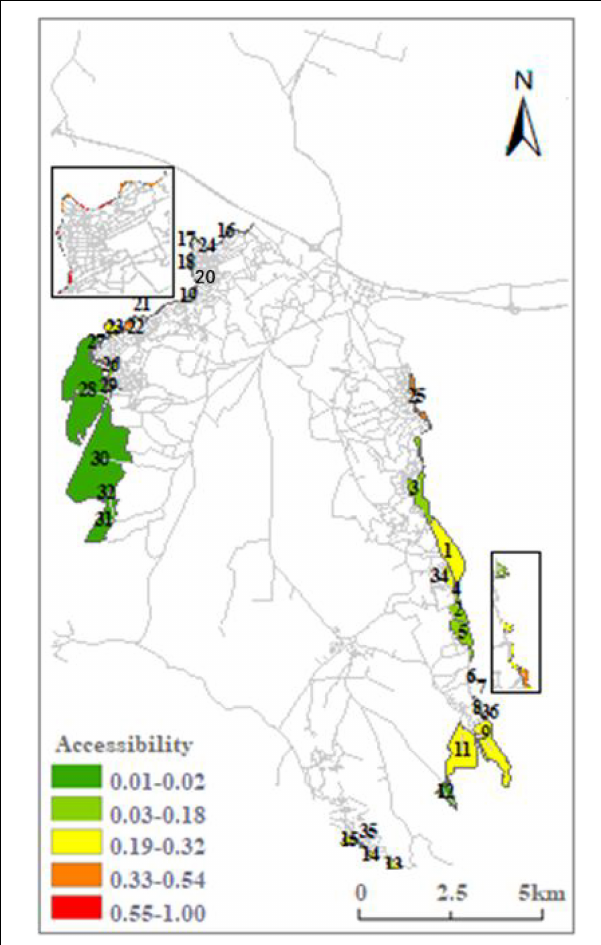
FIGURE 8 | Accessibility of the willingness of residents to pay. FIGURE 9 | Accessibility of the willingness of residents to receive